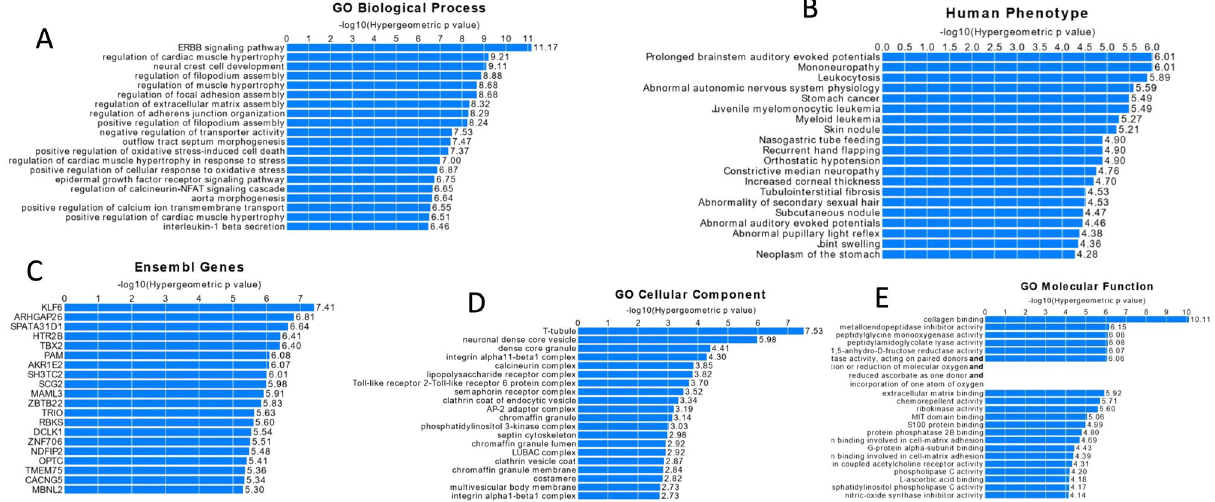
Figure 5. The output of GREAT analyses for five ontology terms linked to the methylation changes for five ontology categories: A—GO Biological Processes, B—Human Phenotype, C—Ensemble Genes, D—GO Cellular Component, E—GO Molecular